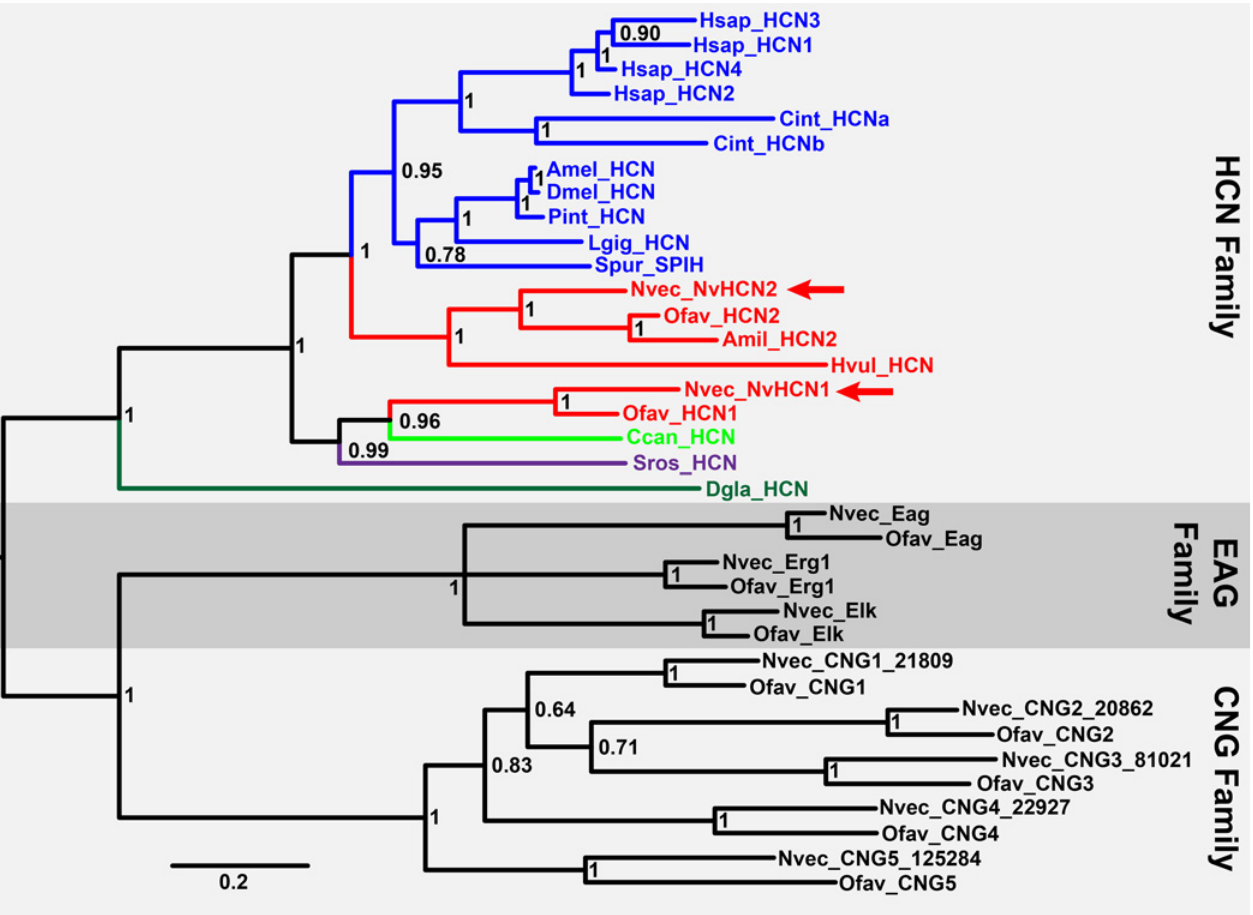
Fig 2. Bayesian inference phylogeny of the HCN channel family. Channels in the HCN family are color coded by phylogenetic group: bilaterians (blue), cnidarians (red), sponge (light green), ctenophore (dark green) and choanoflagellate (purple). The HCN family and the EAG and CNG family outgroups are indicated with shading and labels at the right margin. All outgroup sequences are cnidarian, but are not colored. Posterior probabilities for nodes are indicated and the scale bar is in substitutions/site. Channel names are given at branch tips with species prefixes as follows:; Amil, Acropora millepora , stony coral; Amel, Apis mellifera , honey bee; Ccan, Corticium candelabrum , sponge; Cint, Ciona intestinalis , tunicate; Dmel, Drosophila melanogaster , fruit fly; Dgla, Dryodora glandiformis , ctenophore; Hsap, Homo sapiens , human; Hvul, Hydra vulgaris , hydra; Lgig, Lottia gigantea , limpet; Nvec, Nematostella vectensis , sea anemone; Ofav, Orbicella faveolata , coral; Pint, Panulirus interruptus , lobster; Spur, Stronglyocentrotus purpuratus , sea urchin; and Sros, Salpingoeca rosetta , choanoflagellate. Full and aligned sequences for all branches are given in S1 Table.